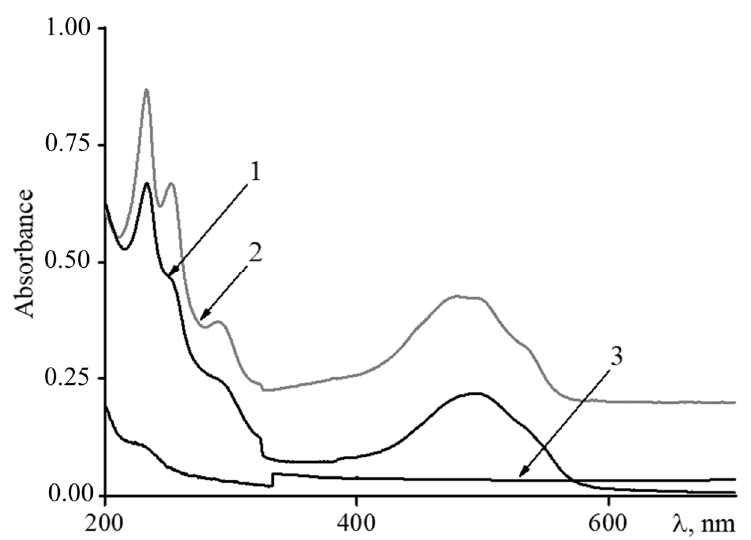
Figure 5. UV spectra of (1) triple nanocomposite NIPAM ‐ PAA ‐β‐ FeO(OH) ‐ DOX, [DOX]/[AC] = 1/1; (2) pure doxorubicin; in all cases CDOX = 3 × 10 − 5 M; (3) external dialysis solution after interaction of DOX and NIPAM ‐ PAA ‐β‐ FeO(OH).